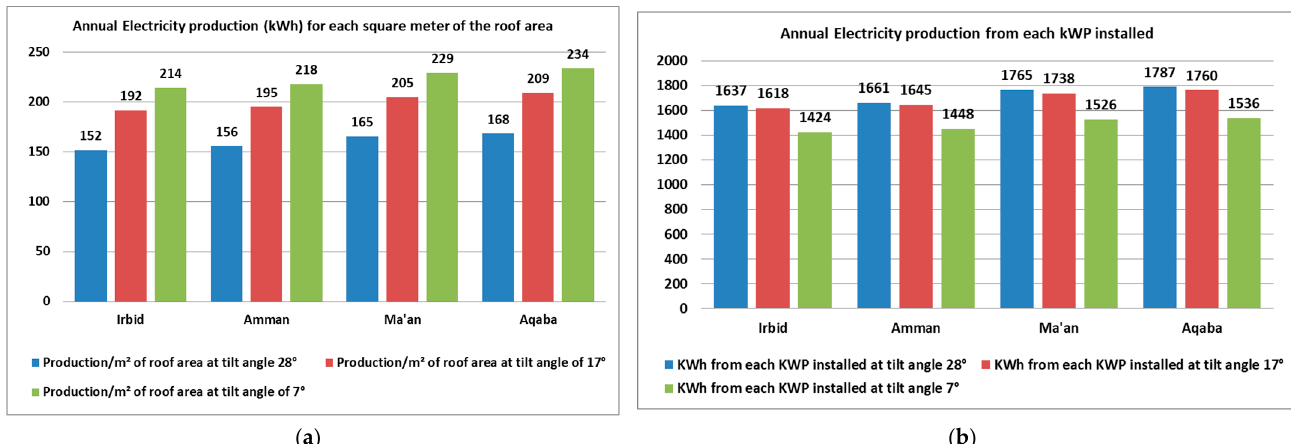
Figure 7. ( a ) Total annual electricity production in kWh for each square metre of the roof area and ( b ) the annual electricity production from each kWp